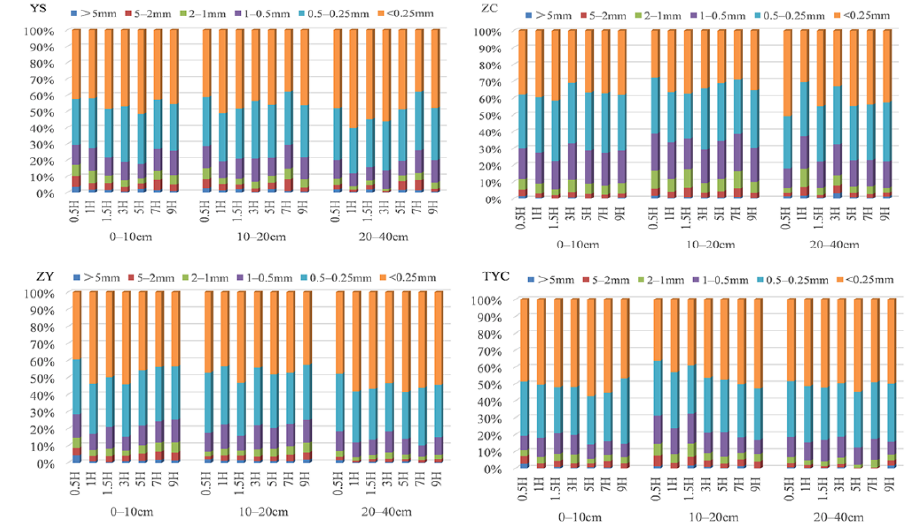
Figure 6. Soil water stable aggregates distribution.